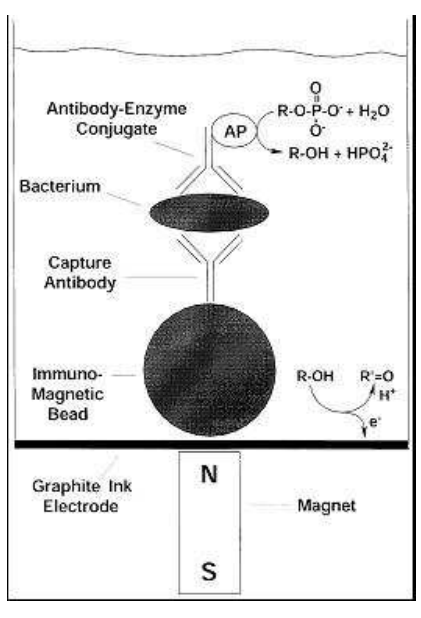
Figure 1. Schematic representation of the enzyme-linked immunomagnetic electrochemical assay (ELIME) ( Reprinted from [9] with permission from Elsevier